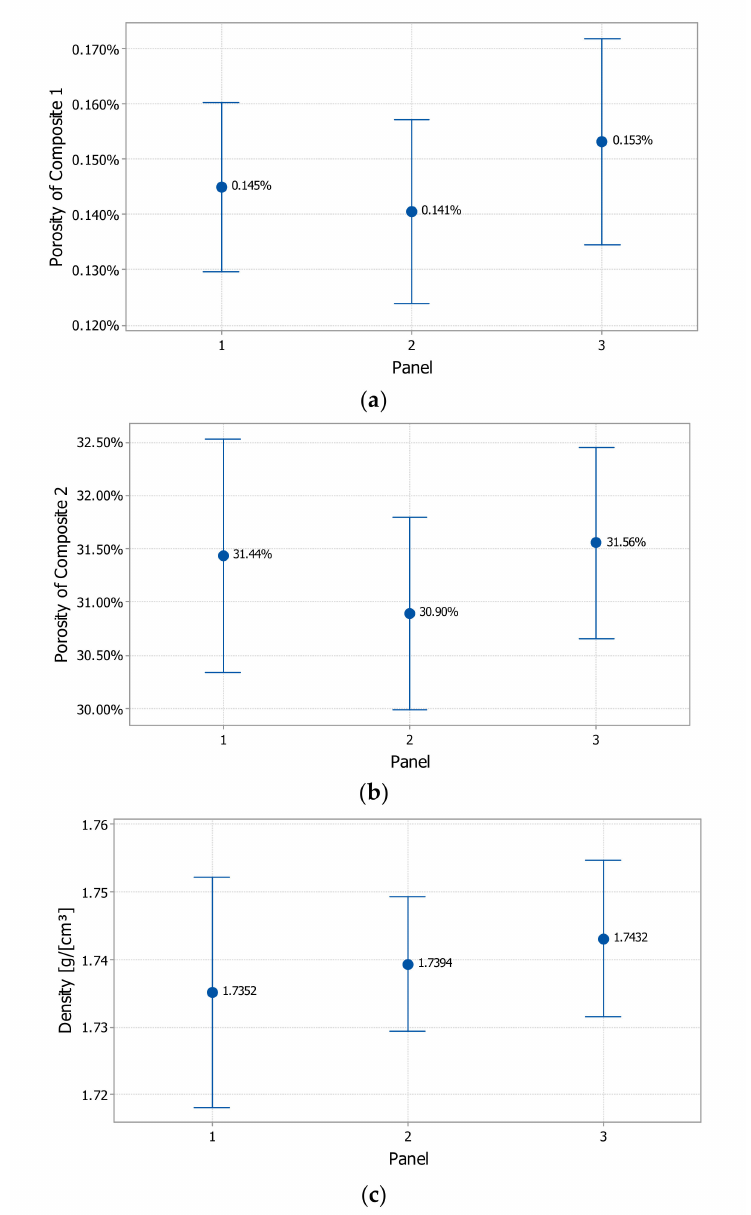
Figure 12. ( a ) The interval plot of the panel porosity for composite 1. ( b ) The interval plot of the panel porosity for composite 2. ( c ) The interval plot of the panel density. Bars are one standard error from the mean. Individual standard deviations were used to calculate the